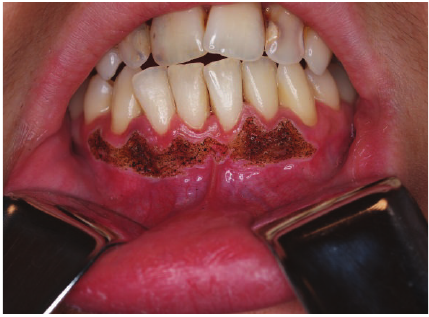
Figure 3: Clinical appearance after CO 2 vaporisation procedure.